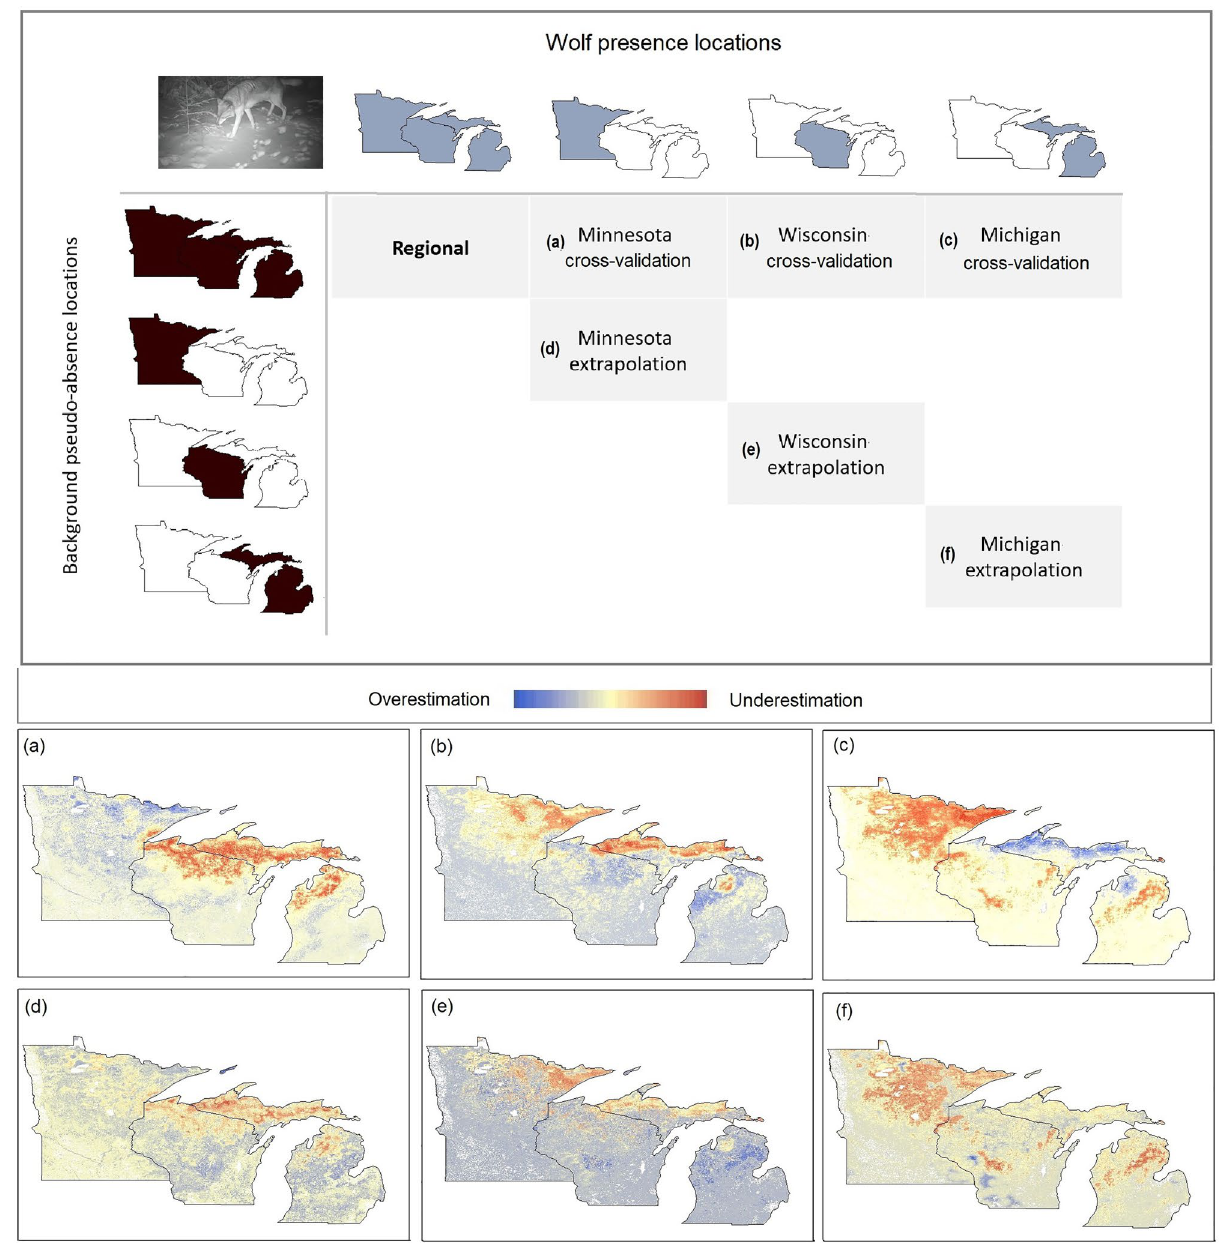
Figure 2. Top: Calibration (wolf presences) vs background (pseudo-absences) locations for the regional model, and cross-validation vs. extrapolation assessments. Bottom: Performance of each single-state model compared to the regional model (Fig. 1) in estimating landscape suitability for wolves, western Great Lakes region, USA, 2017–2020. Maps developed with ArcMap 10.8.1 (desktop.arcgis.com). Wolf photograph: J. Belant, Global Wildlife Conservation